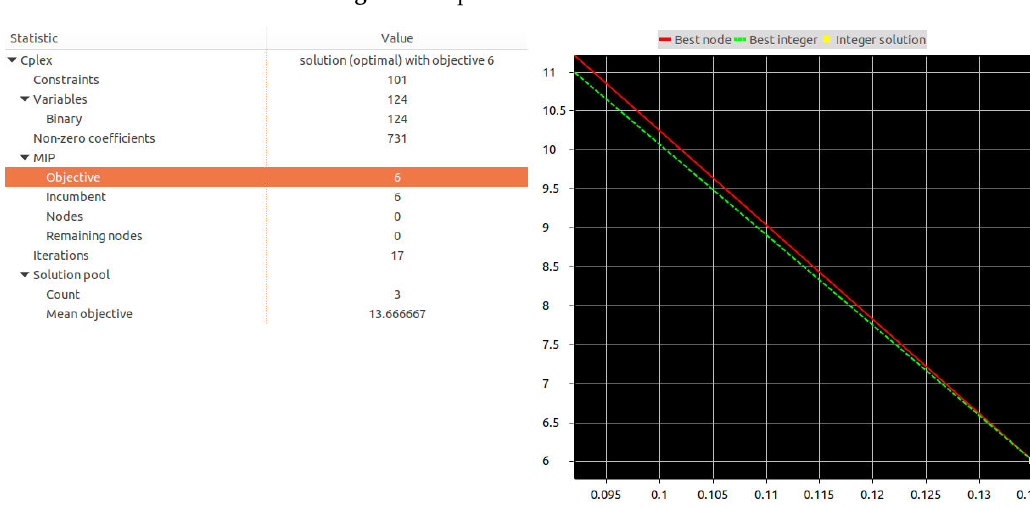
Figure 13. Cplex solution: Commercial.